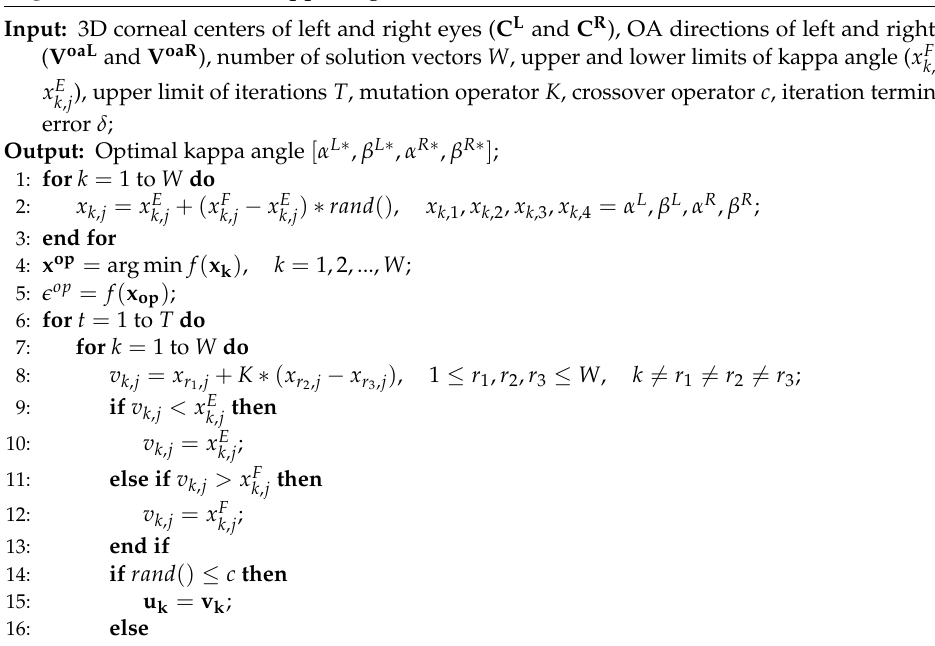
Algorithm 1 Process of kappa-angle